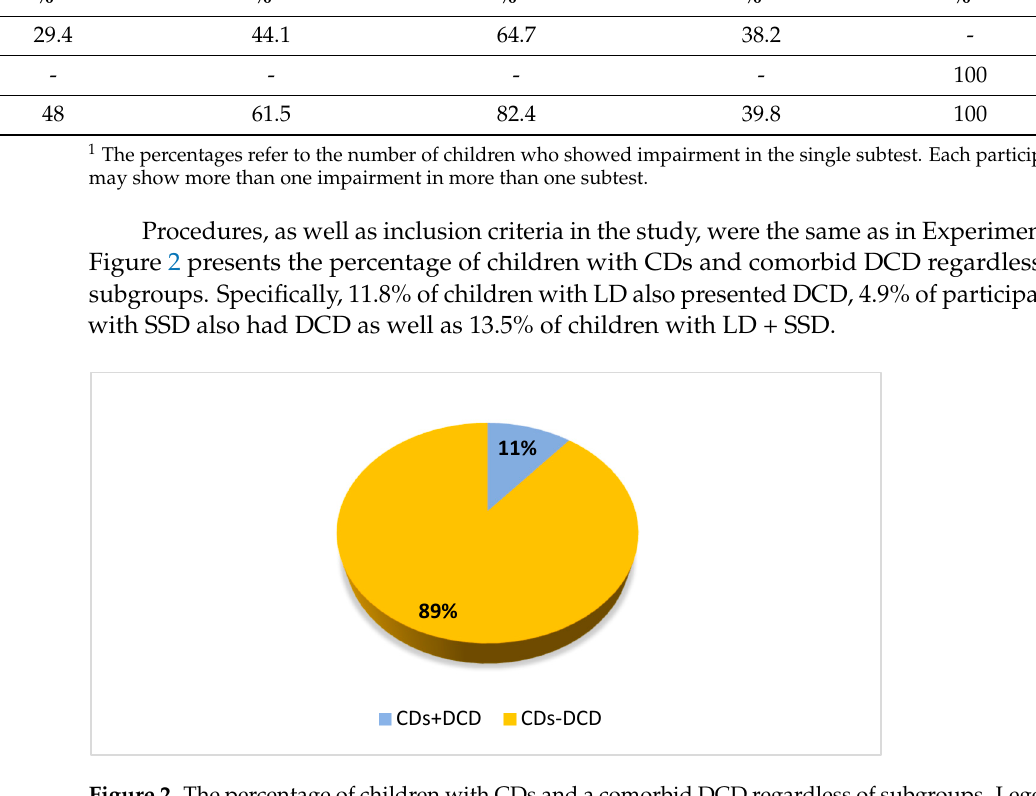
Figure 2. The percentage of children with CDs and a comorbid DCD regardless of subgroups. Legend: CDs + DCD = children with CDs and DCD; CDs-DCD = children with CDs without DCD.